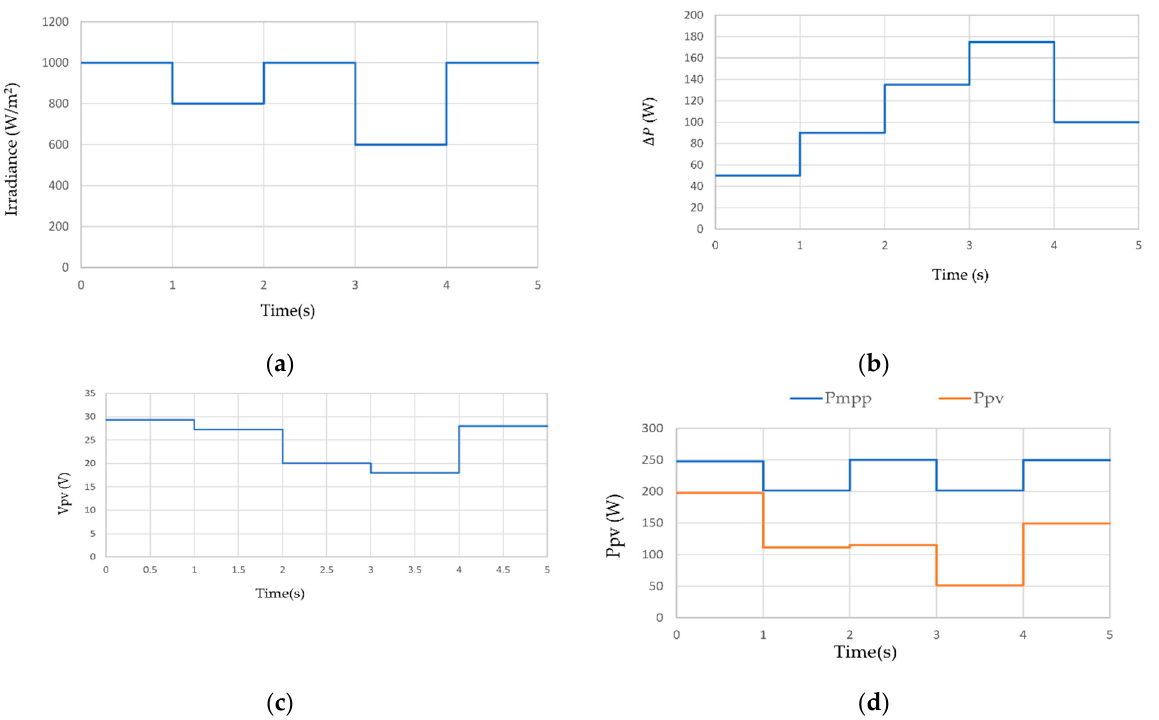
Figure 9. System output waveforms when irradiance and power reserve ratio are both varied: ( a ) Irradiance; ( b ) power reserve ratio; ( c ) PV output voltage; ( d ) PV output power.